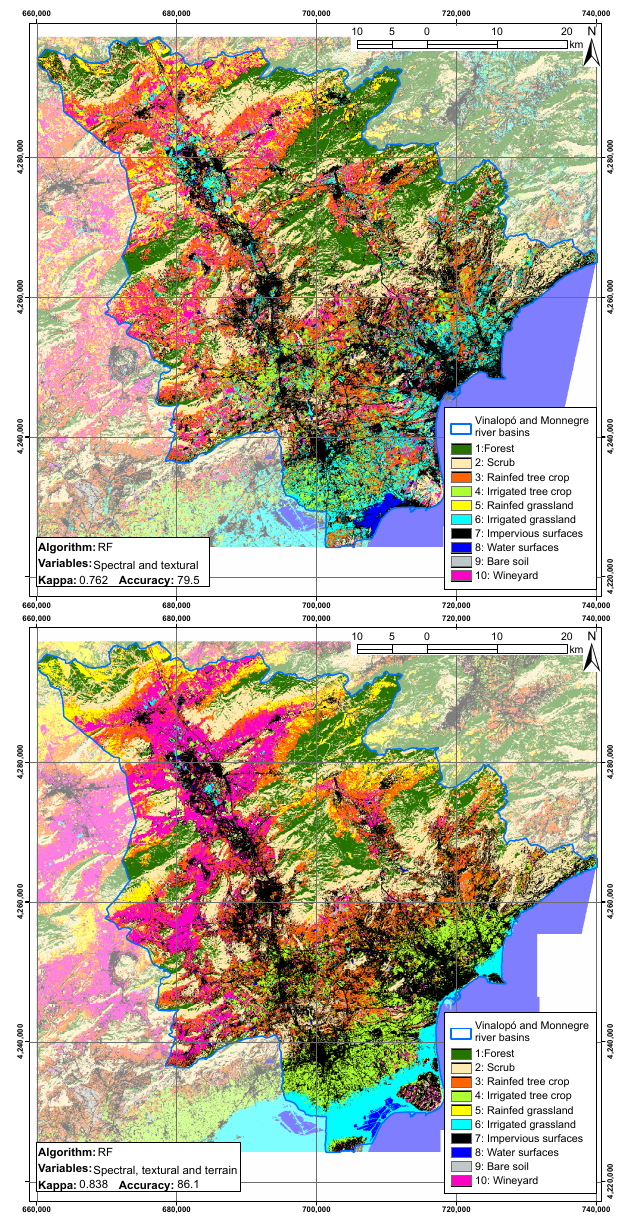
Figure 11. Four-season imagery classification in 2015 using spectral and textural features ( top ) and spectral; textural and terrain features ( bottom ) using RF